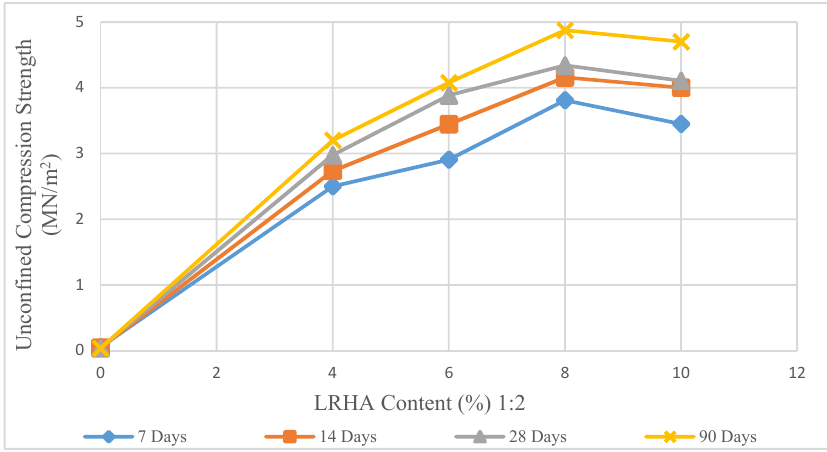
Figure 7. Effect of LRHA content (1:2) on unconfined compression strength.